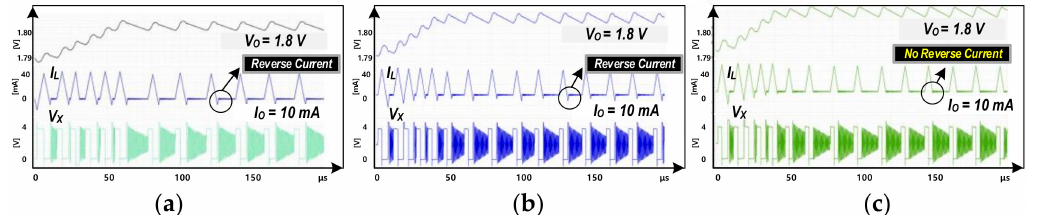
Figure 10. Simulation results of the proposed triple-mode SIC converter in DCM with ( a ) the conventional ZCD, ( b ) the BB-ZCD with uncalibrated o ff set, and ( c ) the BB-ZCD with calibrated o ff